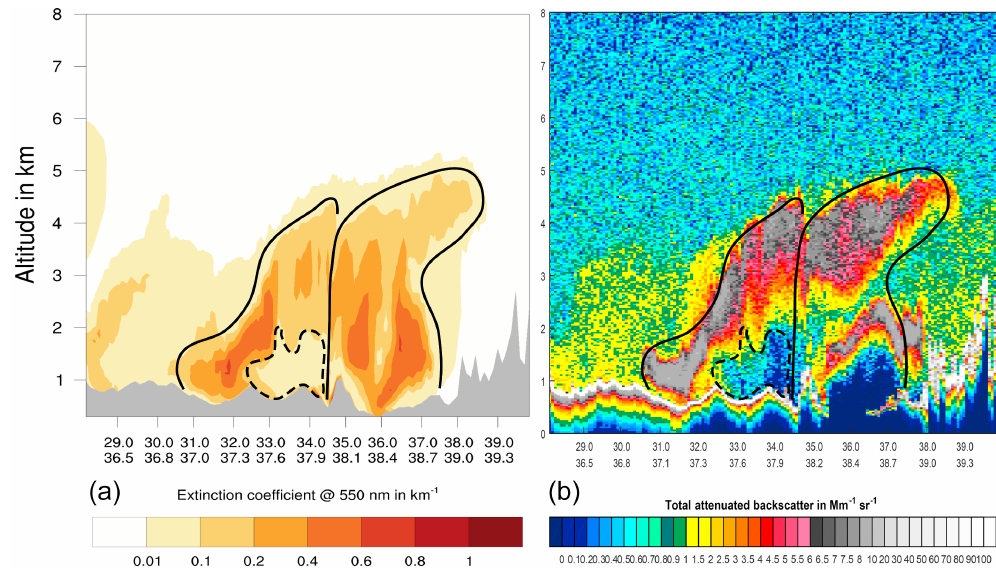
Figure A3. Vertical cross section of ICON-ART model results at 00:00UTC, 7 September, and CALIPSO satellite observations from south to north along the ground track in Fig. A2. (a) ICON-ART mineral dust extinction coefficient. (b) Total attenuated backscatter as measured by CALIOP. No quantitative comparison is possible as two different measures are displayed. The southern solid black line marks the CPO1 and HL region. The dashed line marks the penetrating EM inflow. The northern solid black line marks the CPO2